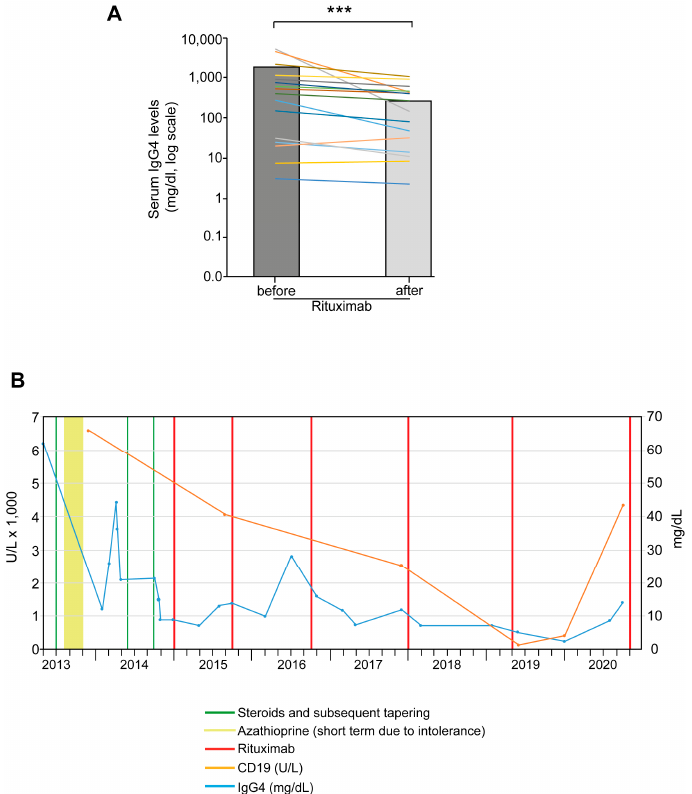
Figure 3. Course of serological markers after RTX therapy. ( A ) Significant decrease in serum IgG4 levels in patients treated with RTX. Bars indicate mean IgG4 levels before and after treatment. Coloured lines show individual development of serum IgG4; *** p < 0.001. ( B ) Representative Illustration of changes in CD19 cell count (orange line) and IgG4 levels (blue line) in an individual patient after steroid pulses (green vertical lines) and several administrations of RTX (red vertical lines). Peak doses of the three steroid pulses were 60, 25, and 30 mg, respectively. The light green bar represents treatment with azathioprine for 4 months.